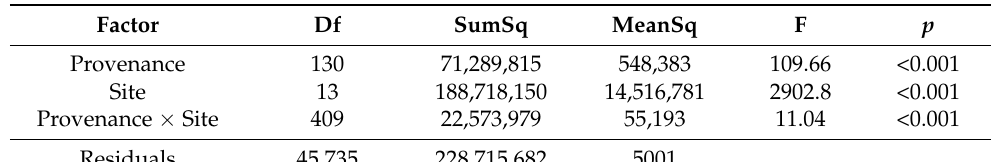
Table 1. Results of two-way ANOVA for height variability among provenance populations and common garden sites.